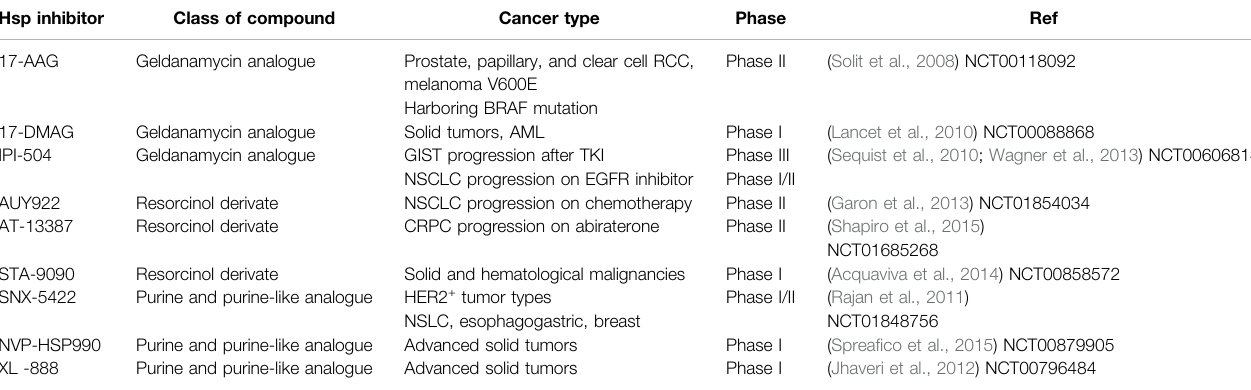
TABLE 1 | Summary of Hsp90 inhibitors reaching clinical